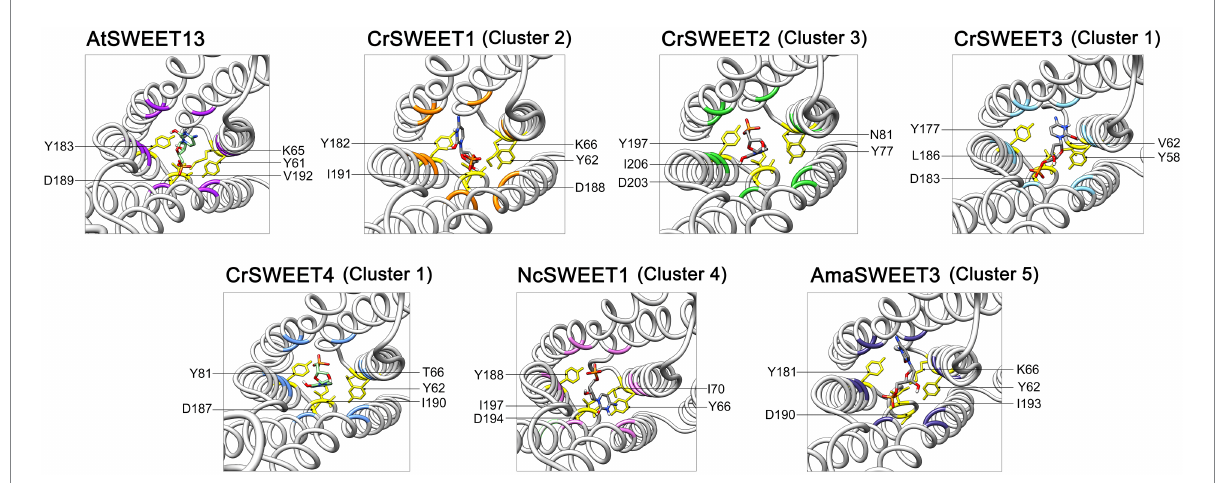
FIGURE 7 Predicted extrafacial hinge residues of CrSWEET1 to 4, NcSWEET1 and AmaSWEET3, compared with AtSWEET13. The DCM substrate associated with the extrafacial gate residues is shown. Residues were determined by alignment with the previously characterised extrafacial hinge residues for AtSWEET13. The structures are viewed from the lumenal or extracellular side through the pore